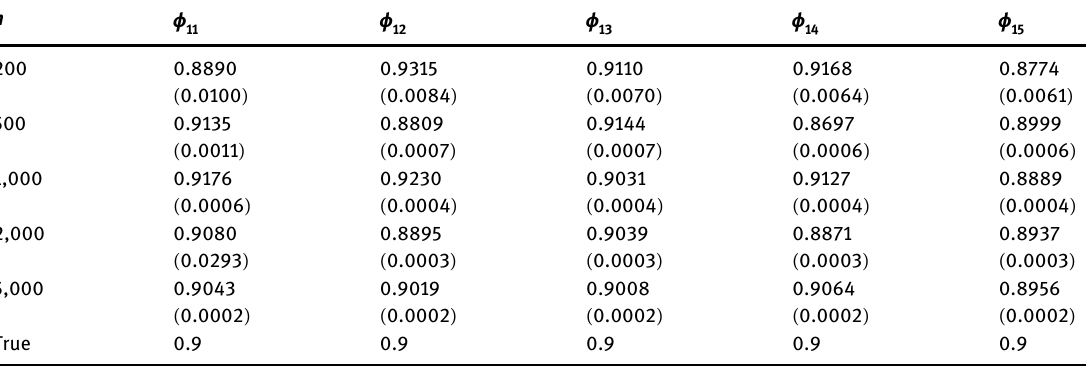
Table 2: Estimates of autoregressive coe ffi cients of the measurement errors. ( Standard errors are provided and were computed using 1,000 paths